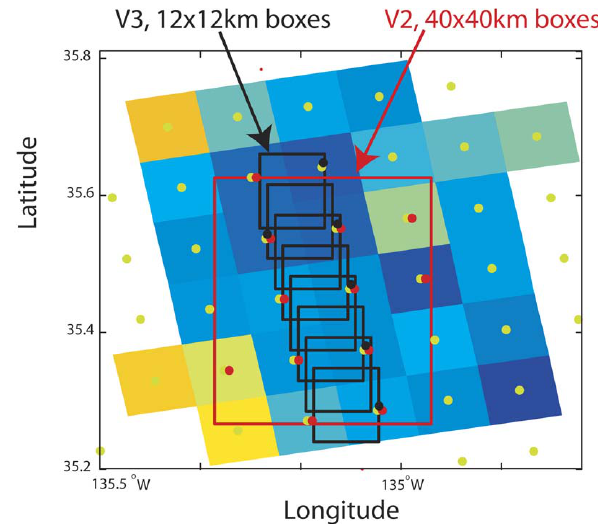
Fig. 2. Geometry for comparing MODIS AOD retrievals (solid boxes) to CALIOP V2 (40km-average) and V3 (5km-average) AOD retrievals. Black boxes around V3 retrieval locations represent the optimal sampling of the MODIS AOD retrievals (see Sect 2.3 for explanation of symbol colors).